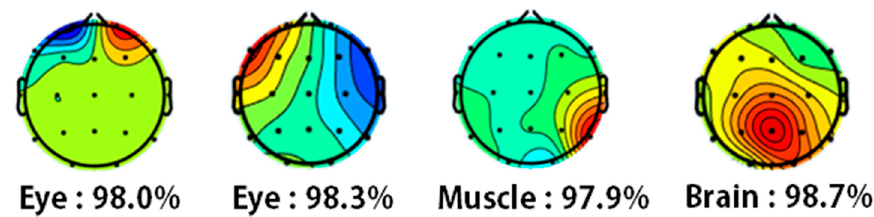
Figure 2. Independent components as classified by ICLabel. Perceived Stress Scale